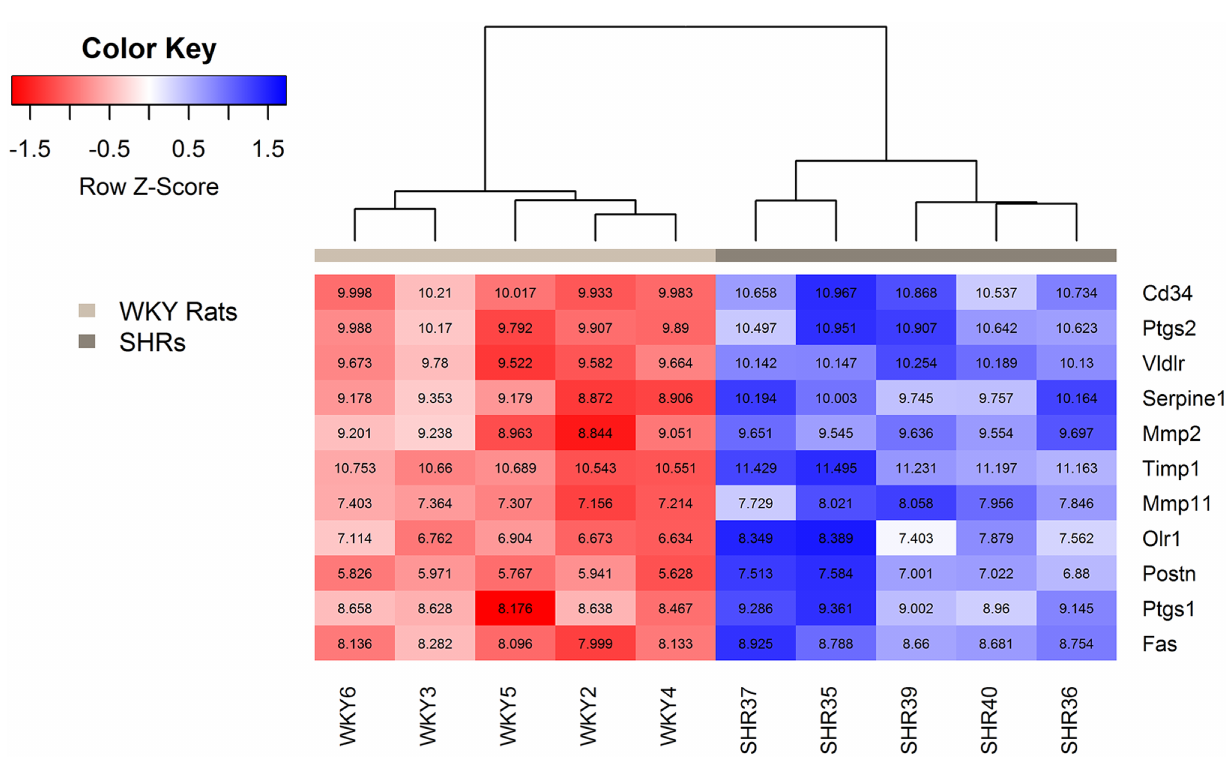
Fig 3. Heat map of genes verified by qPCR. Box color and color key show the expressionlevel differencesbetweenWKY rats (n = 5) and SHRs (n = 5), reportedas the Z score, which is the scaled gene expressionmeasurement (scaled row-wise, mean = 0, SD = 1). As expected, WKY rats and SHRs are groupedseparatelydue to distinct expressionpatterns betweengroups. The numbersin the boxes represent normalizedexpressionvalues of each gene for each rat.